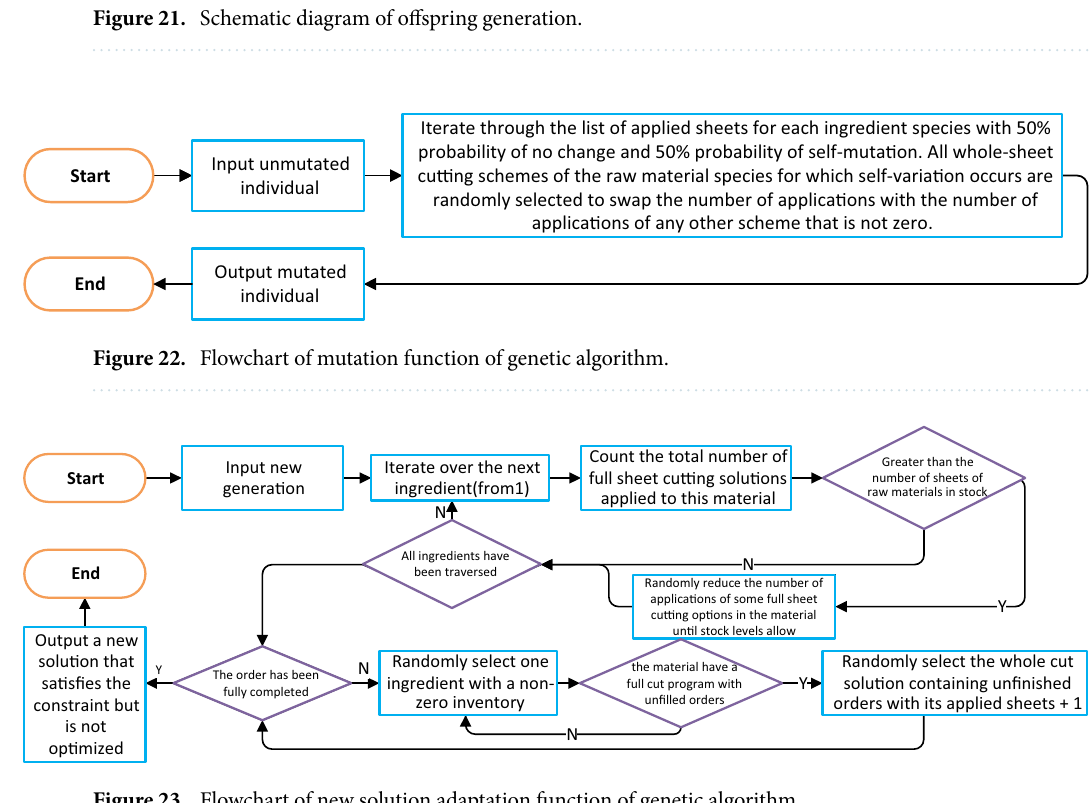
Figure 23. Flowchart of new solution adaptation function of genetic